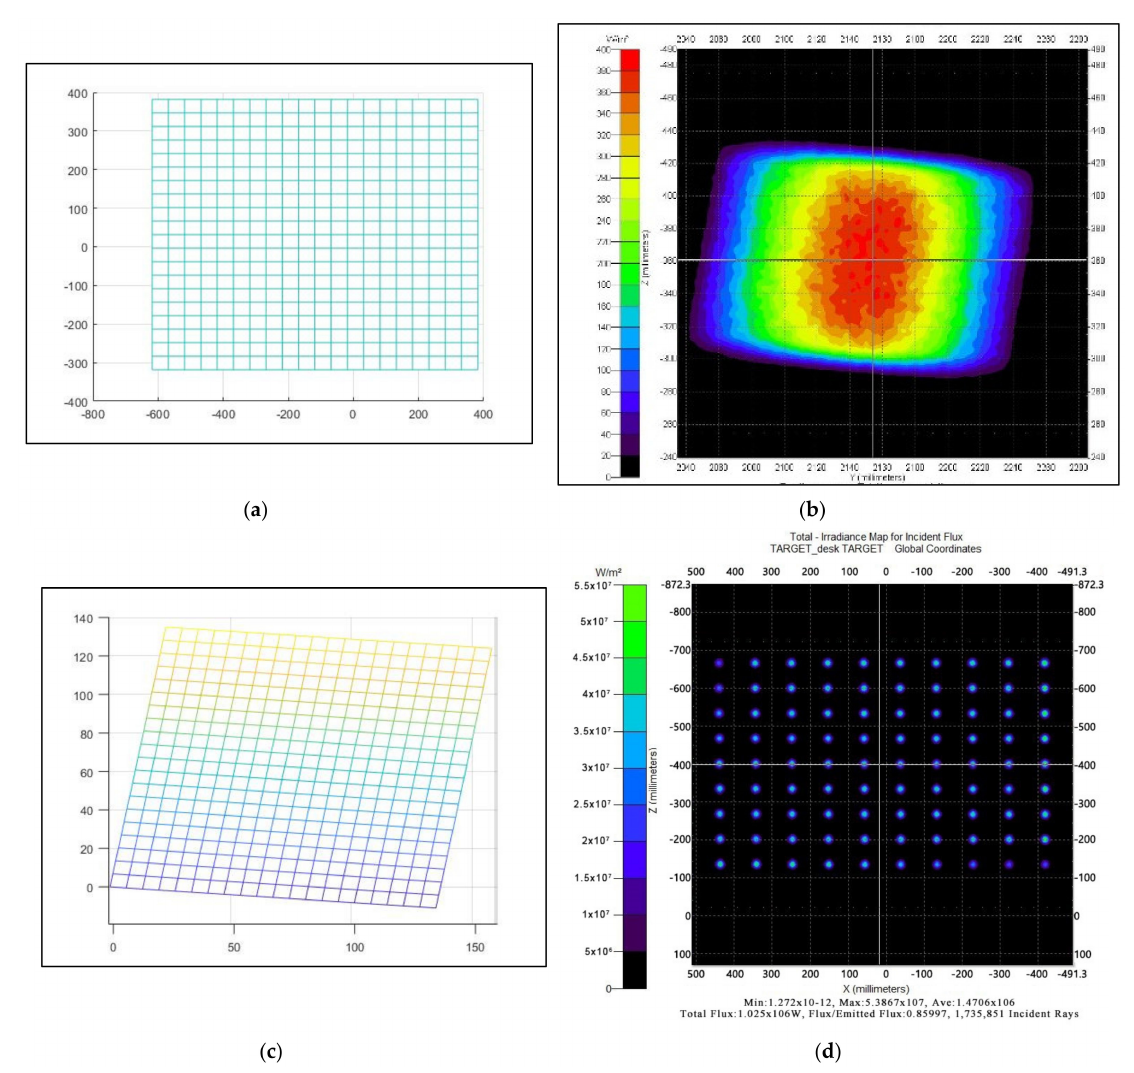
Figure 15. ( a ) Prescribed symmetric grid-reflected plane to arrange the focal point; ( b ) asymmetric illuminance map of the target plane; ( c ) prescribed asymmetric grid-reflected plane; and ( d ) symmetric illuminance map of the target plane observed using a point light source.